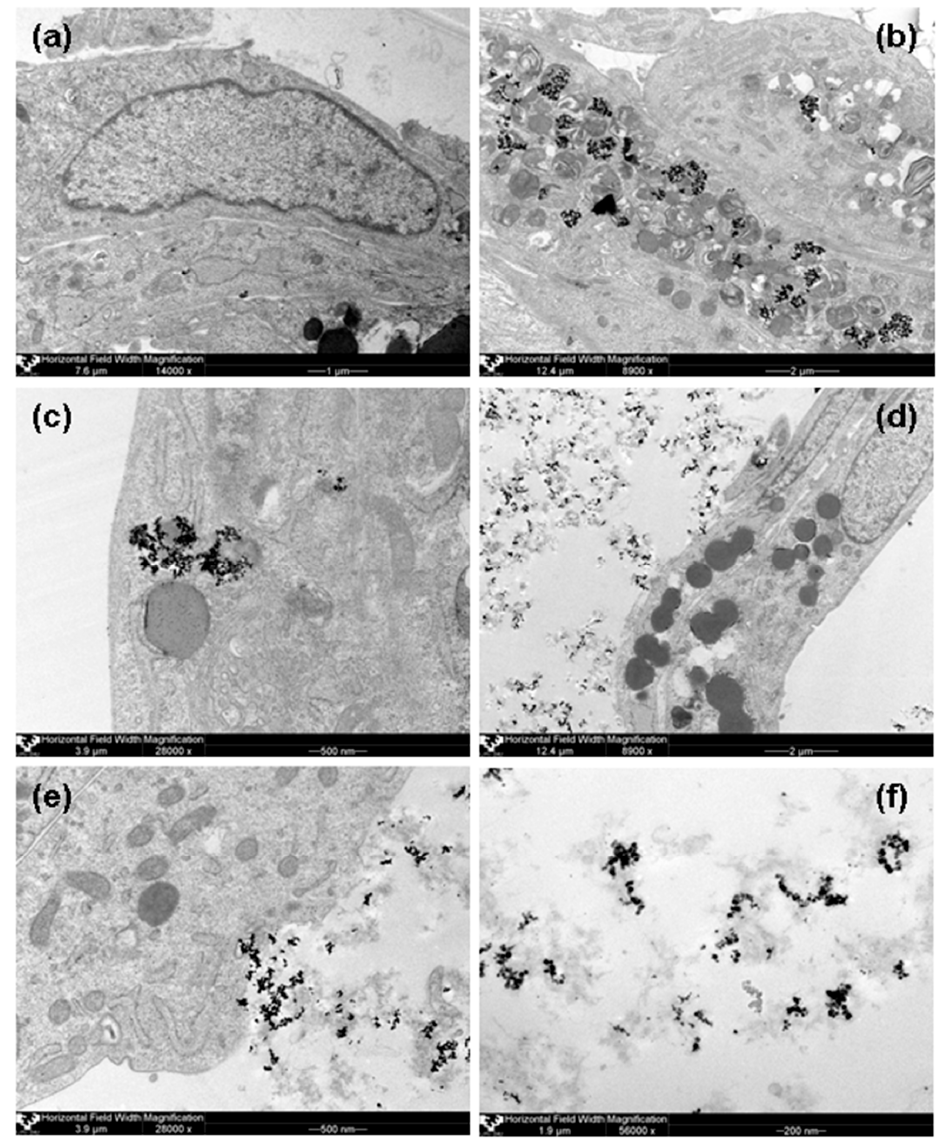
Figure 8. TEM of human mesenchymal stem cells. ( a )—control AMMSCs culture grown without MNPs. AMMSCs cells after 24-h contact with MNPs of suspension of iron oxide MNPs without chitosan (FF1) at a dose of 100 MTDs: ( b )—magnification ×8900, ( c )—magnification ×28,000. AMMSCs cells after 24-h contact with iron oxide MNPs of suspension with chitosan (FF2) at a dose of 100 MTDs: ( d )—magnification ×8900, ( e )—magnification ×28,000. Aggregates of LTE MNPs encapsulated